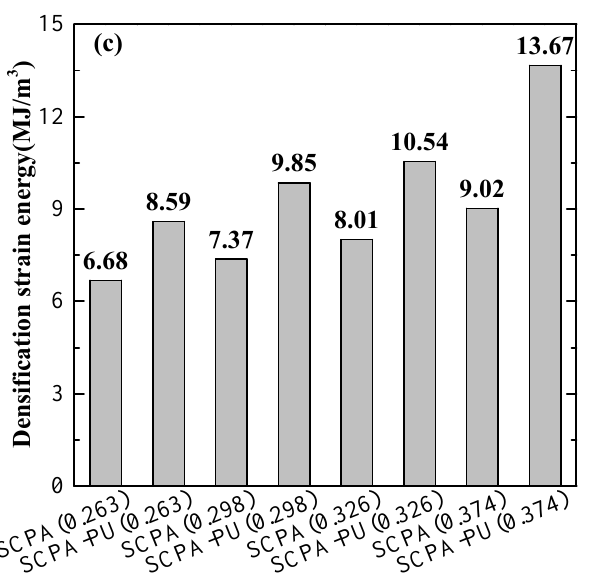
Figure 6. Comparison of SCPA and SCPA-PU composites specimens, with different relative density values for ( a ) the densification strain; ( b ) plateau stress; and ( c ) densification strain energy.